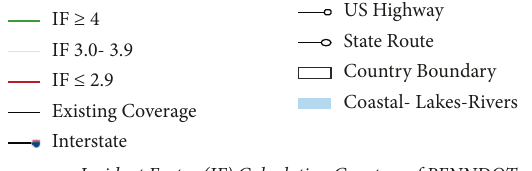
Figure 1: ASAP coverage